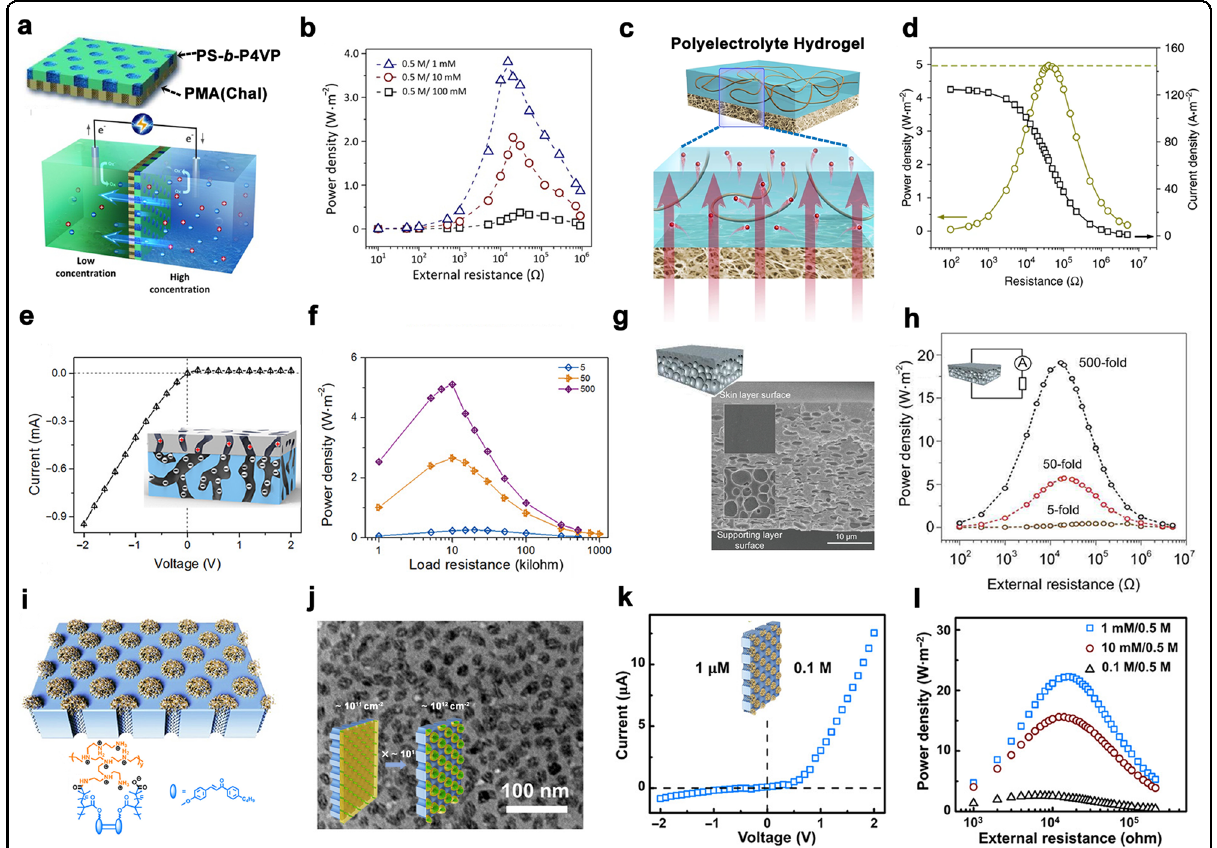
Fig. 6 Polymer membrane-supported hierarchical nanochannel membranes. Janus block copolymer membranes composed of two self- assembled membranes ( a ) and the corresponding power density evaluation ( b ). Reproduced with permission 25 . Copyright 2017, American Chemical Society. Polyelectrolyte hydrogel-based heterogeneous membrane ( c ) and its power density evaluation ( d ). Reproduced with permission 54 . CC BY (https://creativecommons.org/licenses/). I ‒ V curve of the Janus ionomer membrane in 3 M KCl ( e ) and power density evaluation under different salinity gradients ( f ). Reproduced with permission 26 . CC BY 4.0 (https://creativecommons.org/licenses/by-nc/4.0/). Asymmetric sulfonated poly(ether ether ketone) membrane ( g ) and the corresponding power density evaluation ( h ). Reproduced with permission 55 . CC BY (https:// creativecommons.org/licenses/). Schematic of mushroom-shaped block copolymer nanochannel membrane ( i ) and its TEM image ( j ). The inset of ( j ) displays the density of mushroom-shaped nanochannels, which further reaches ~10 12 cm − 2 . I ‒ V curve of the mushroom-shaped block copolymer nanochannel membrane under an extremely high salinity gradient ( k ) and output power densities ( l ). Reproduced with permission 57 . CC BY 4.0